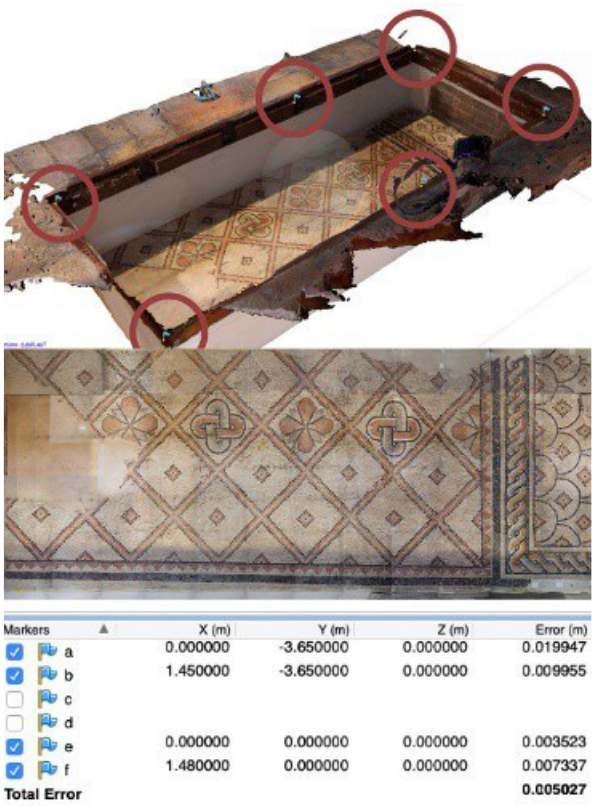
Figure 13. 3D model of mosaic E, measurements, and orientation with target points, acquired by direct survey